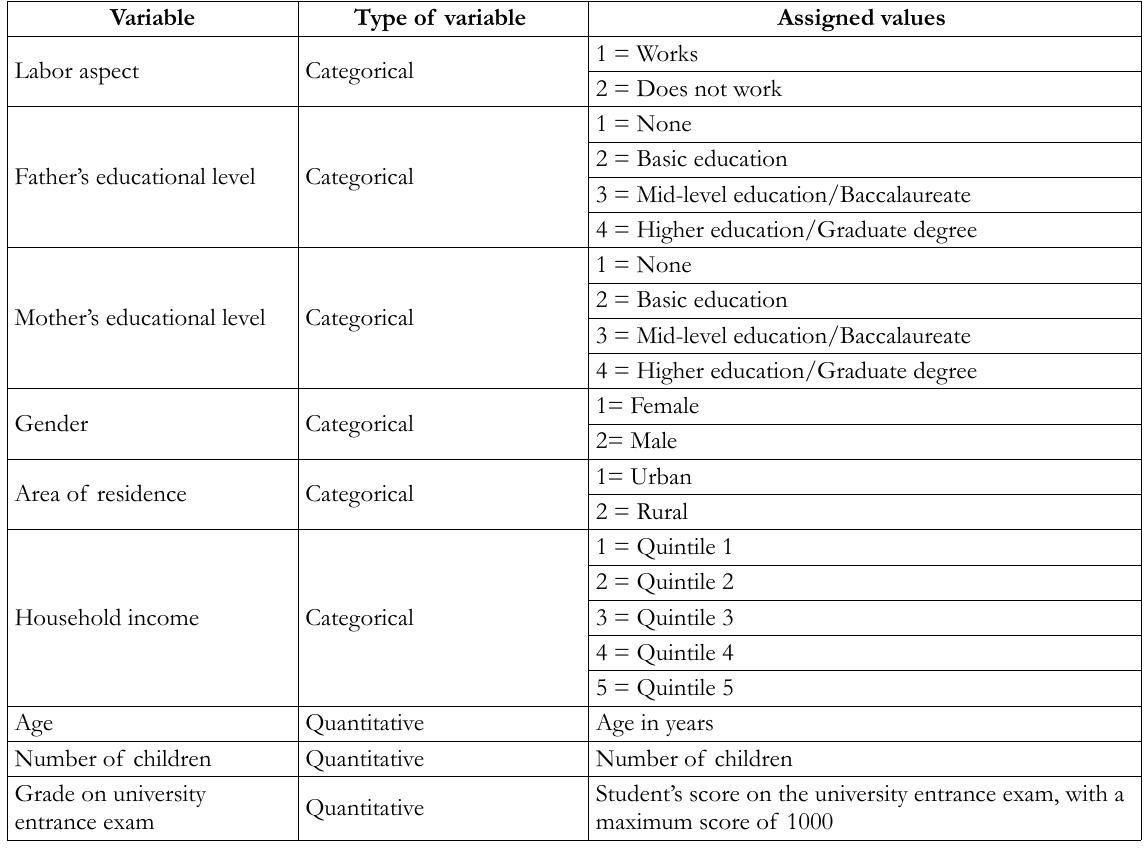
Table 3. Characterization of the study variables